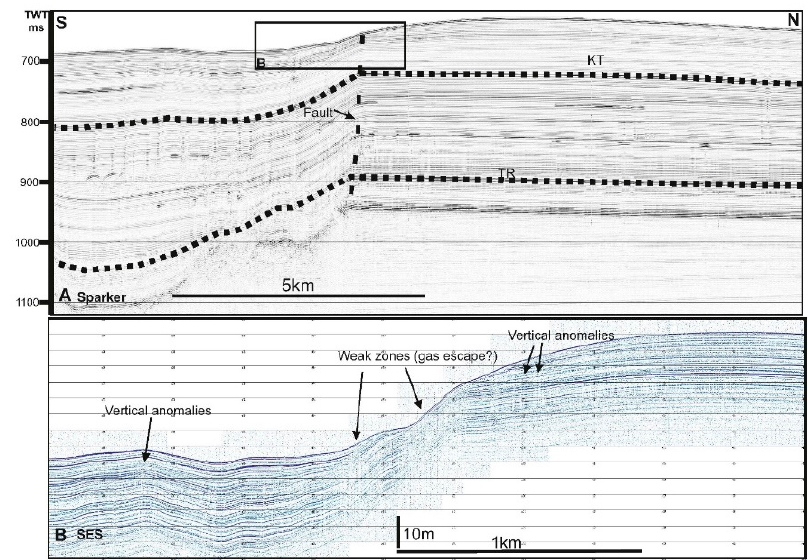
Figure 13. Contourite fault-controlled drift on the southern slope of the Derbent Basin near the Apsheron Sill. ( A ) Fragment of the profile (sparker) roughly S-N along foot of the slope. Main unconformities: TR—Turkanian regression, KT—Khvalinian transgression. ( B ) Enlarged fragment of ultra-high-resolution seismic reflection profile (SES) showing in detail uppermost sedimentary layer with weak acoustical transparent gas escape zones. Location in Figure 2.